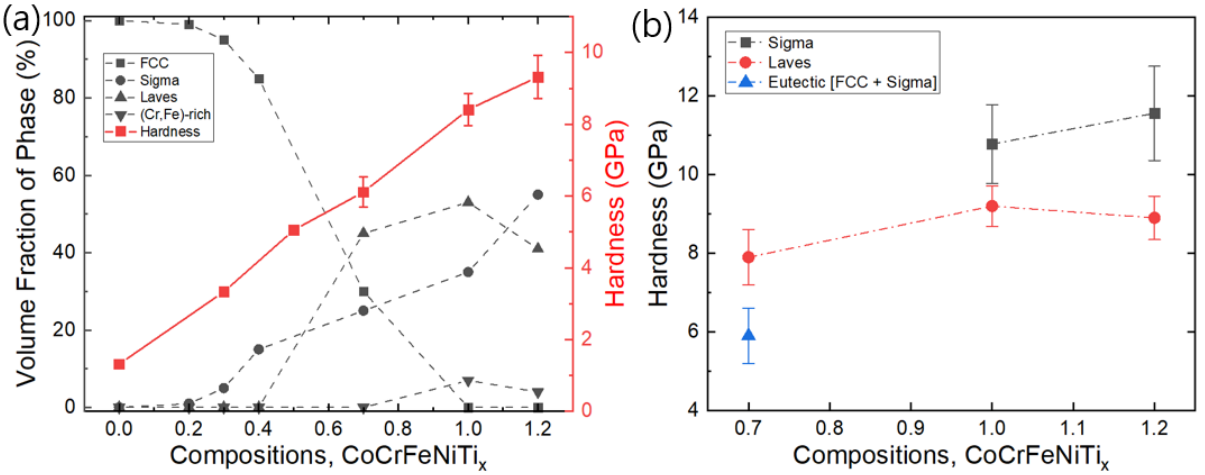
Figure 3. ( a ) Variations in alloy macro-hardness in accordance with the volume fraction of various phases. ( b ) Micro- hardness for individual phase for the CoCrFeNiTi x alloys. Note that the hardness data for Ti0, Ti0.3 and Ti0.5 in ( a ) was obtained from the literature [27] .